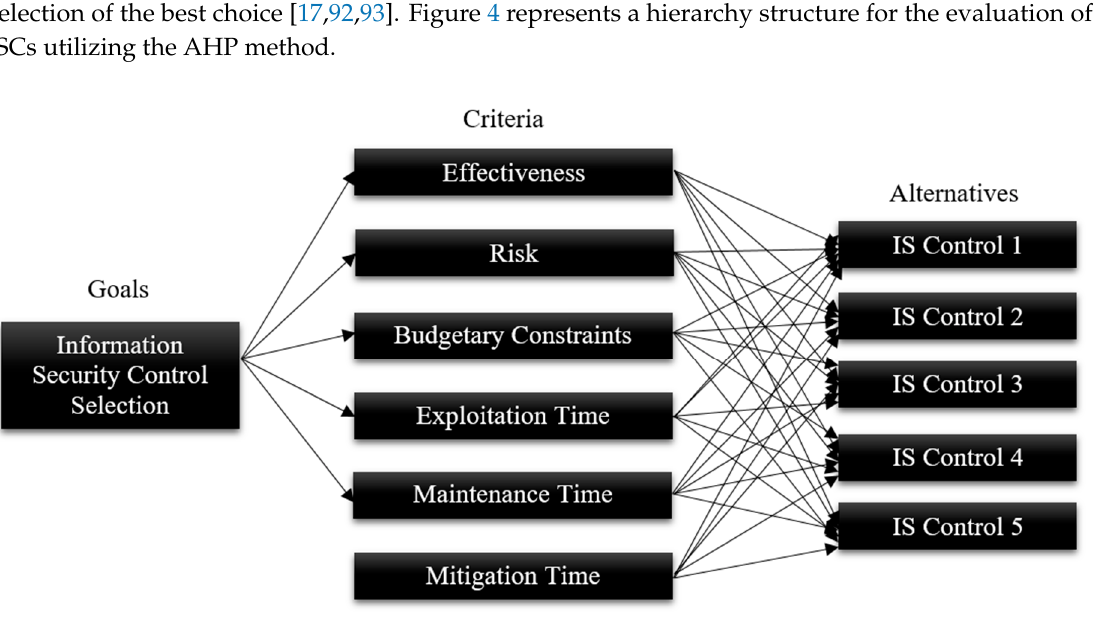
Figure 4. Hierarchy structure of the analytical hierarchy process (AHP).